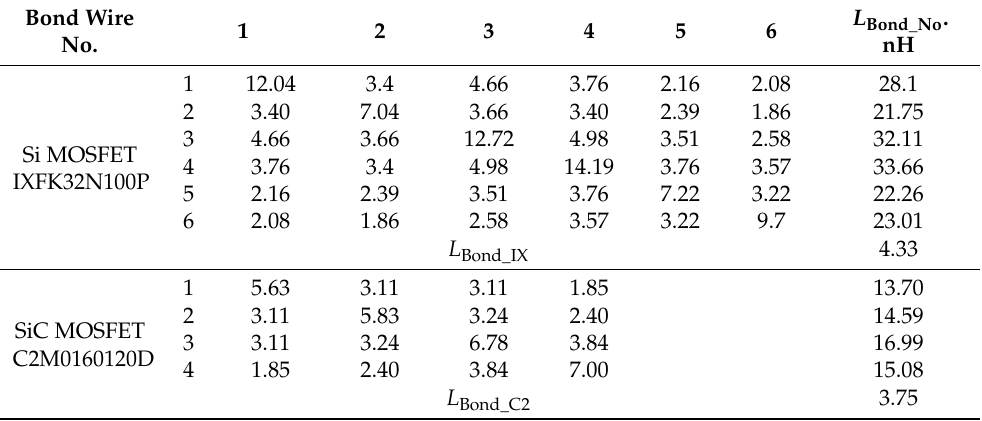
Table 2. Parasitic inductance for IXFK32N100P and C2M0160120D discrete MOSFETs. Bond